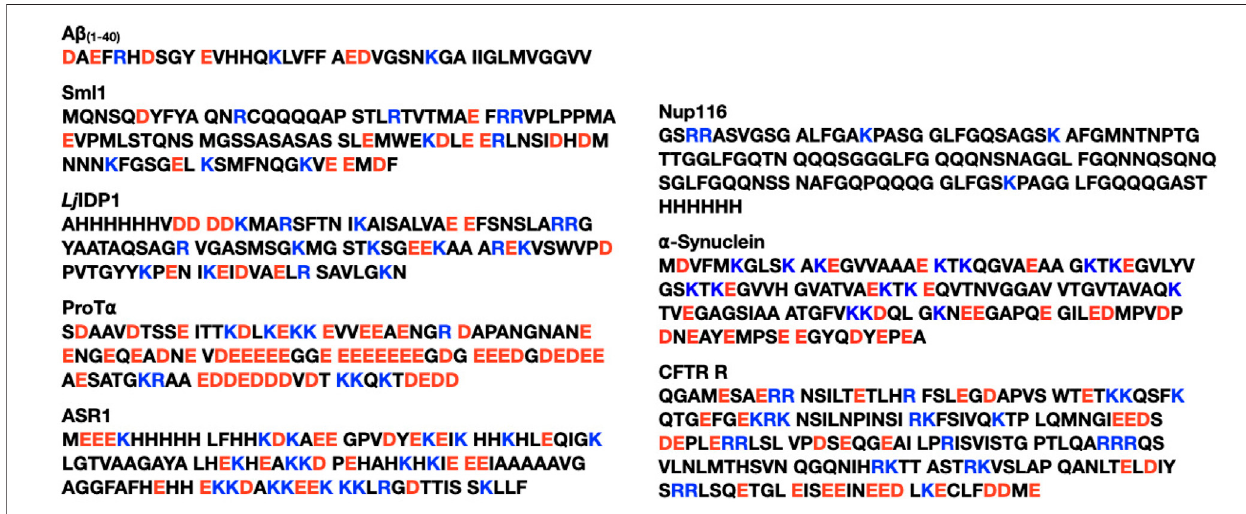
FIGURE 2 | The eight naturally occurring IDPs used in the study. Glutamic acid (E) and aspartic acid (D) are colored in red for negative charge, and lysine (K) and arginine (R) are colored in blue for positive charge. The eight IDPs are from Frembgen-Kesner et al. (2015).